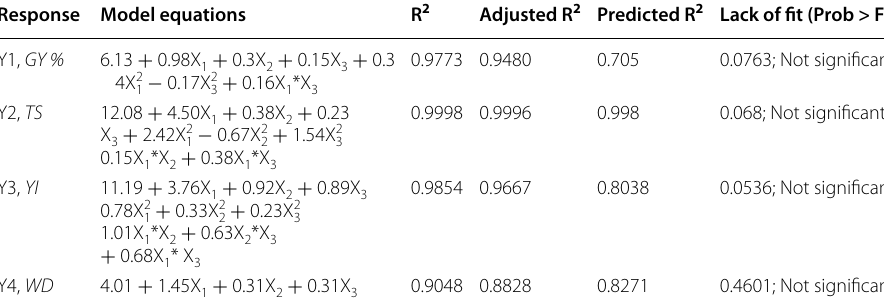
Table 2 Statistical analysis for desirability (Model equations) Response Model equations